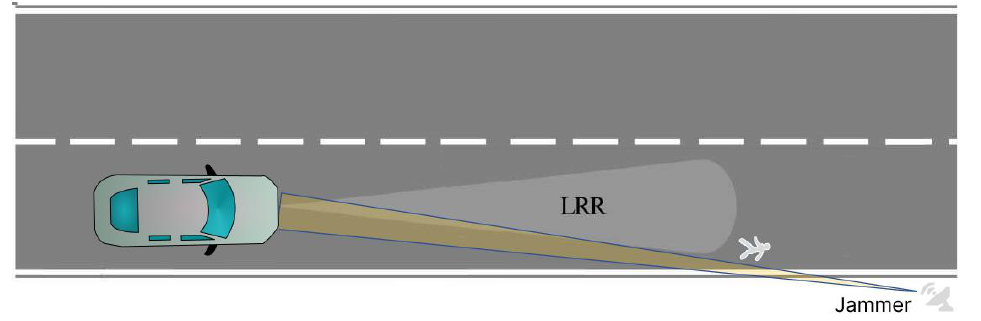
Figure 1. Scenario-1. A realistic false pedestrian echo generation by CFT. Scenario-2